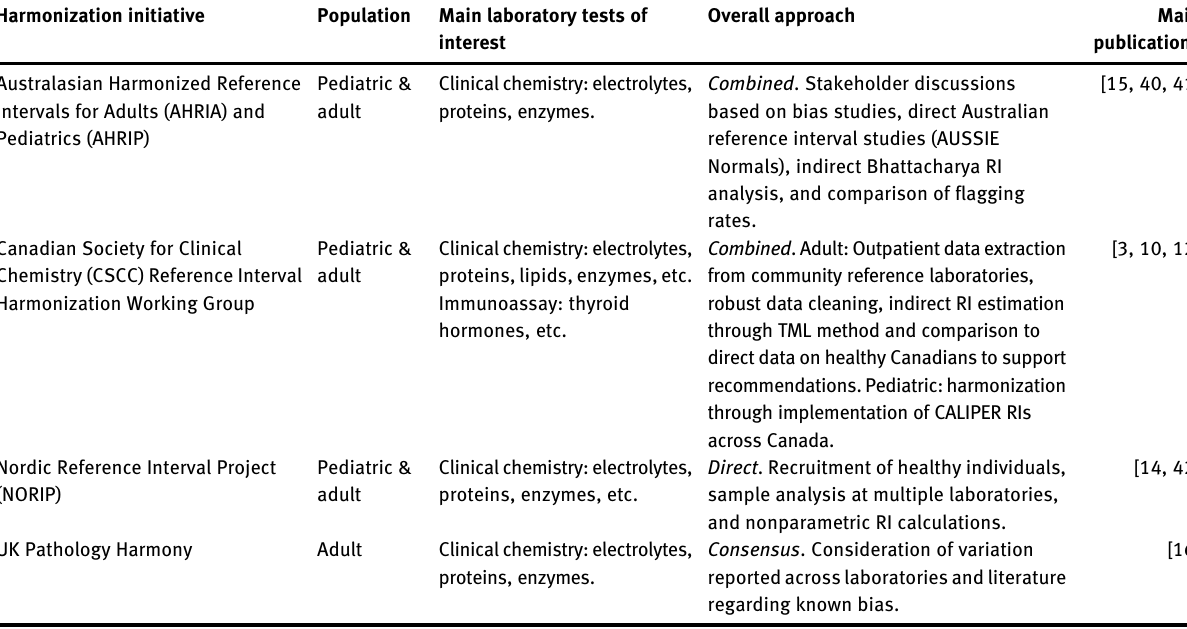
Table  : Summary of active reference interval harmonization initiatives and their respective